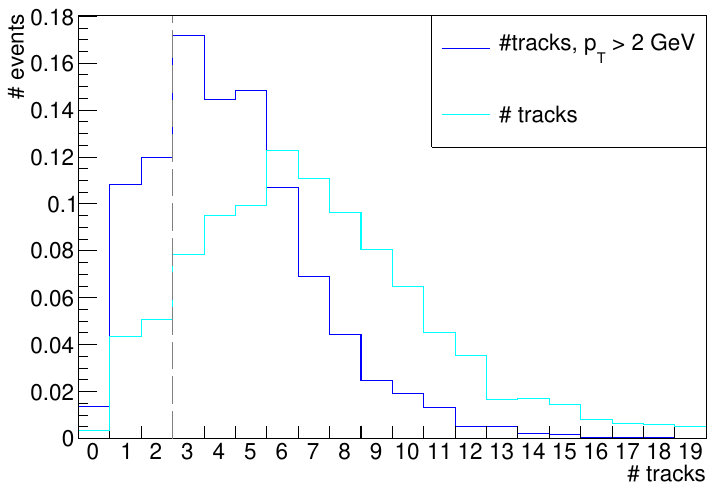
Figure 5 . Number of tracks of jets originating from t ¯ t with log line shows the number of tracks with p T > 2 GeV, the lighter blue line the number of all tracks for such a